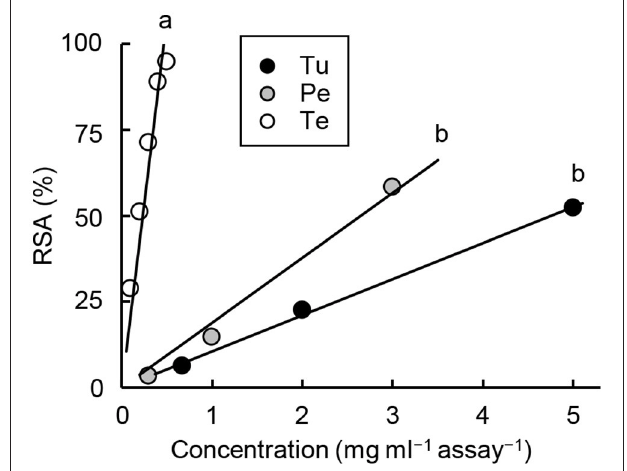
FIGURE 6 | Radical scavenging activities (RSA) of methanol extracts from T. urticae (Tu), peach pollen (Pe), and tea pollen (Te). Different letters on the regression line indicate statistical significance (Tukey method, P < 0.001). Regression line formulas are Tu: y = 10.5x [SE for slope = 0.2, r 2 = 0.999, F (1, 2) = 2,488, P = 0.0004]; Pe: y = 18.9x [SE for slope = 1.2, r 2 = 0.989, F (1, 2) = 267.8, P = 0.0037]; and Te: y = 213.1x [SE for slope = 12.2, r 2 = 0.984, F (1, 4) = 303, P = 6.39 × 10 − 5 ].